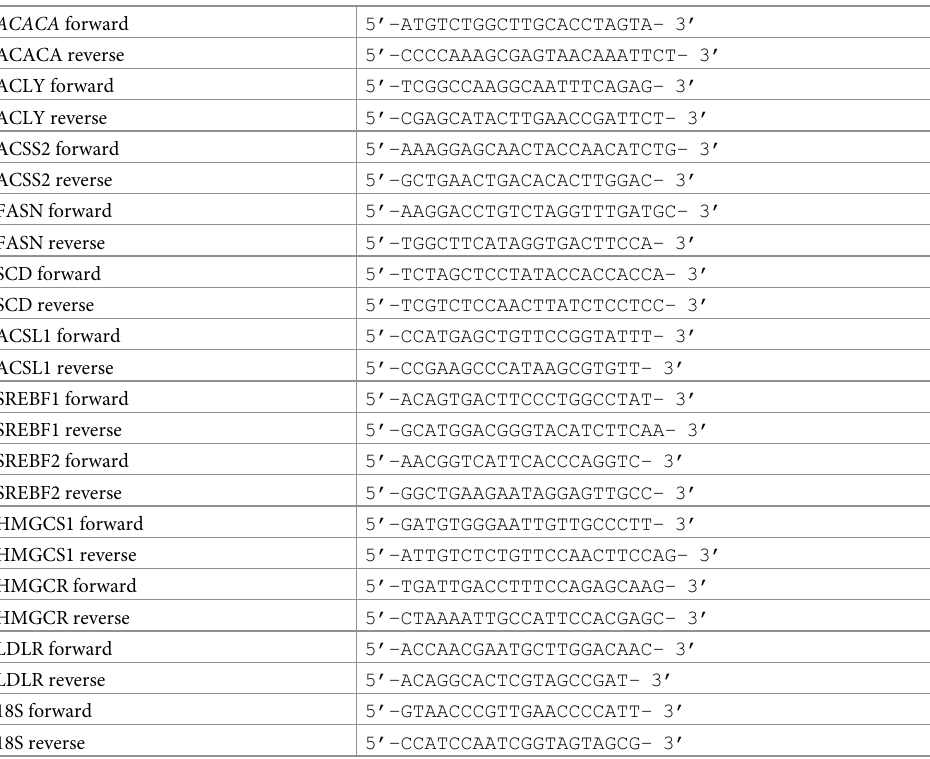
Table 1. Primers used for